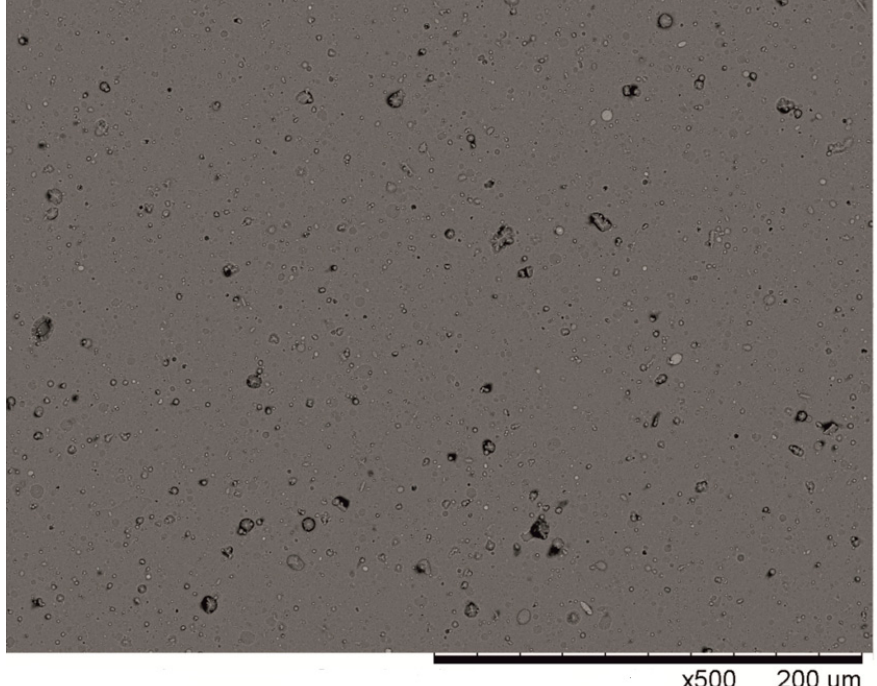
Figure 2. An image of the hybrid layer produced using a scanning electron microscope, consisting of Cr layer and CrN, produced on AISI 1045 medium carbon steel.